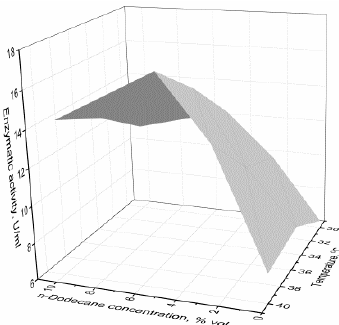
Figure 7. Variation of α -amylase activity with n -dodecane volumetric fraction and temperature in the third day of fermentation (pH = 6). third day of fermentation (pH =